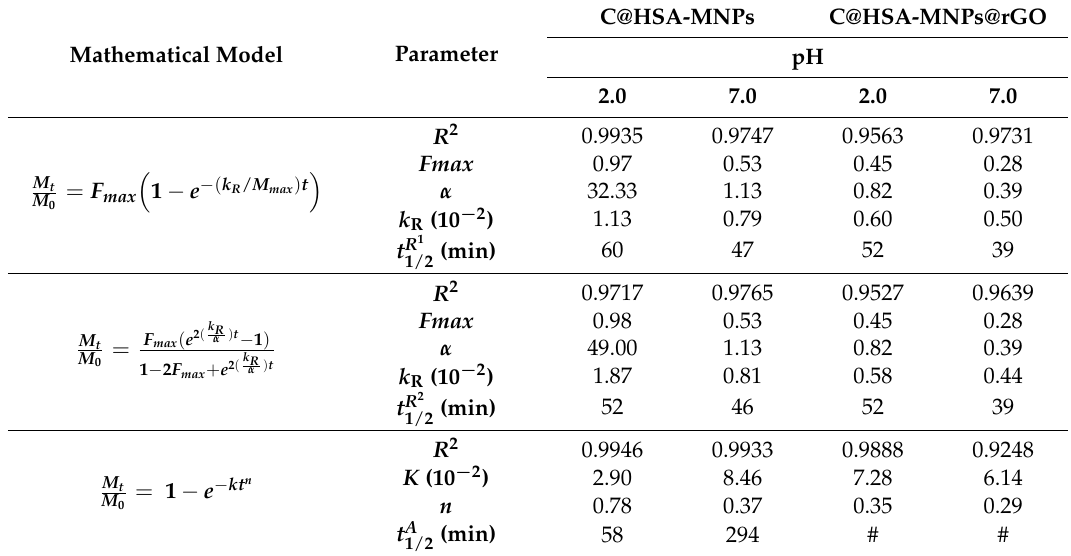
Table 1. R 2 values and kinetic